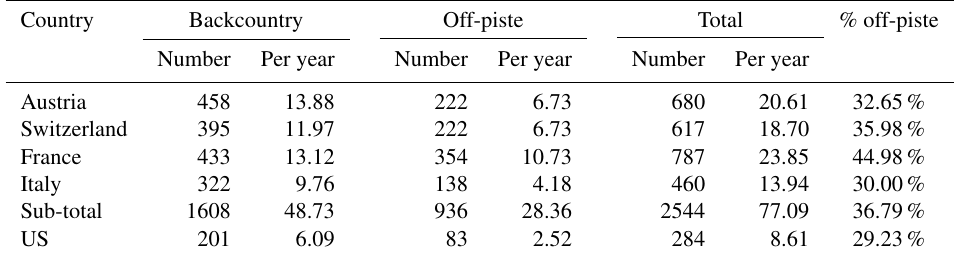
Table 1. Number of avalanche fatalities and annual average (off-piste, backcountry and total) of five countries within the winter periods 1983/1984–2015/2016.